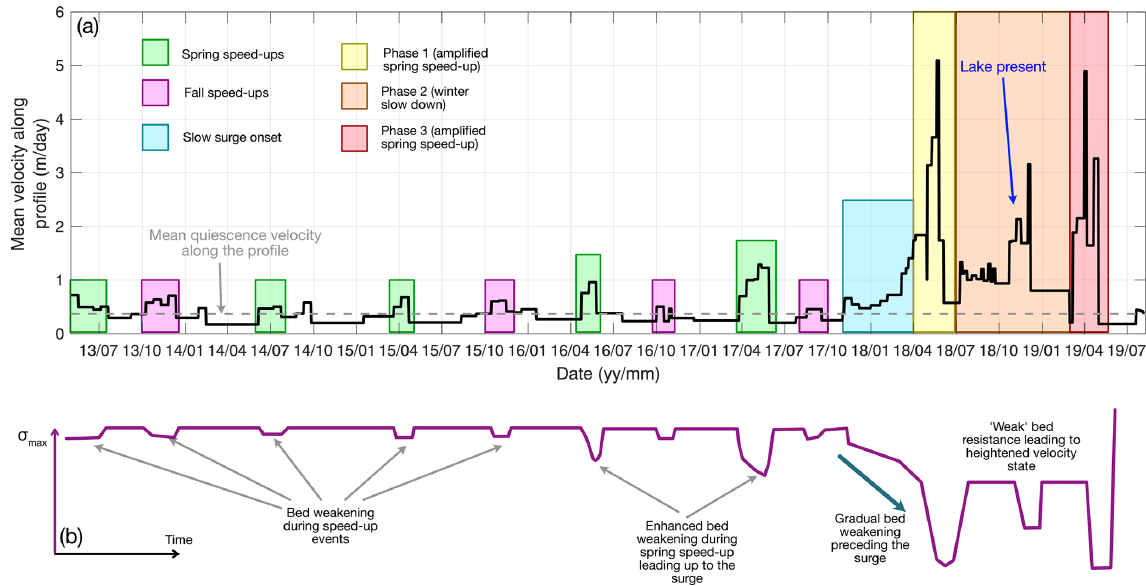
Figure 7. (a) Spatial average of surface velocities along the profile of Shisper Glacier as a function of time and (b) conceptual representation of the maximum resistive stress σ max